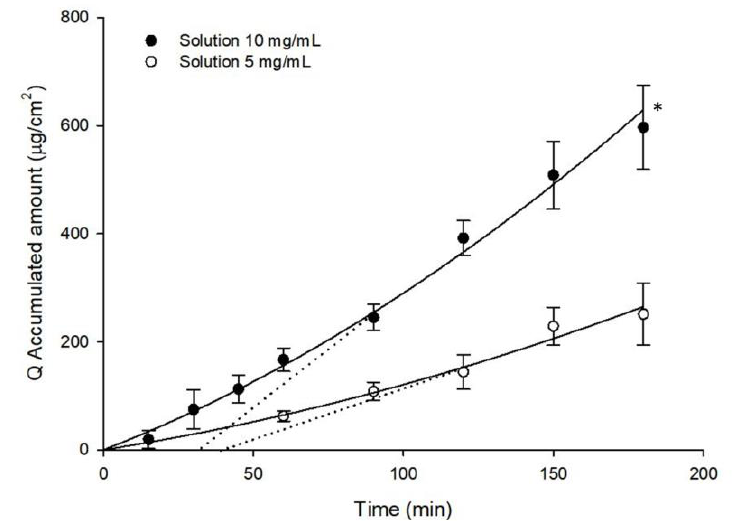
Figure 3. Accumulated amounts of GSH in the receptor compartment (Q, µ g / cm 2 ) as a function of time, obtained from samples employed in ex-vivo trans-scleral diffusion studies of different solutions. The dotted line represents the estimated lag time (t 0 ) calculated by intersecting with the x -axis of the linear regression. (Mean ± SD; n ≥ 3) * p < 0.05.